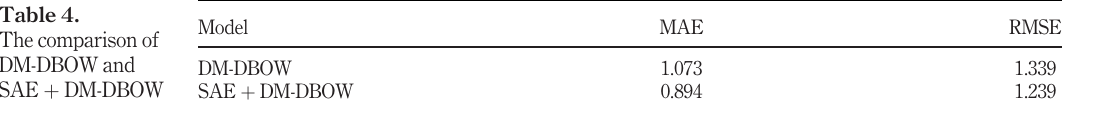
Table 3. Parameters selection of Doc2Vec model